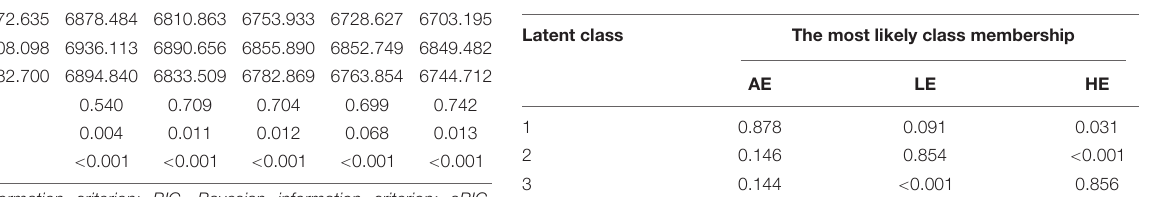
TABLE 3 | Average latent profile class probabilities for the most likely class membership (row) by latent class (column) ( n =